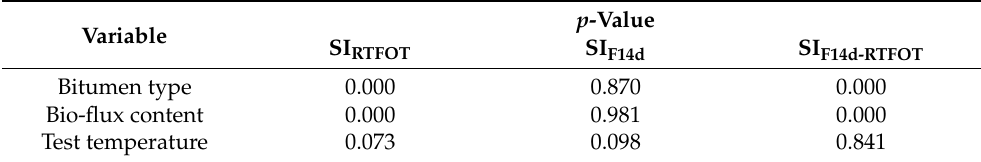
Table 6. Determined p -values for the